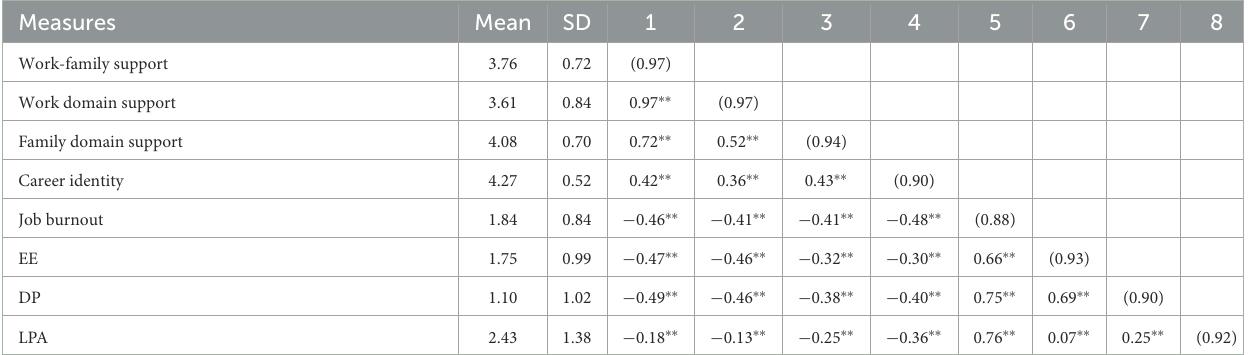
TABLE 2 Means, standard deviations, and correlations among all variable.